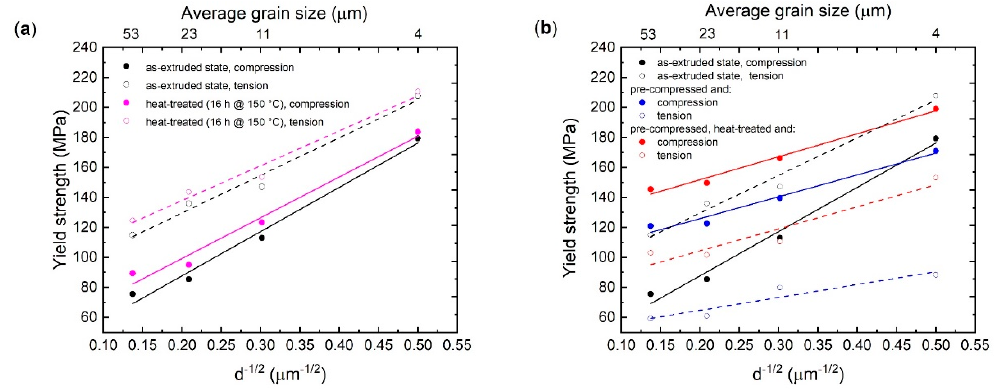
Figure 6. The Hall–Petch relation for the ZX10 alloy: ( a ) e ff ect of HT for as-extruded condition; ( b ) e ff ect of precompression with subsequent HT. Table 1. Tensile–compression yield asymmetry values in MPa for di ff erent states of the ZX10 extrusions. strength value (standard deviations of stresses is 2 MPa), i.e., negative values represent the reversed tensile–compression yield